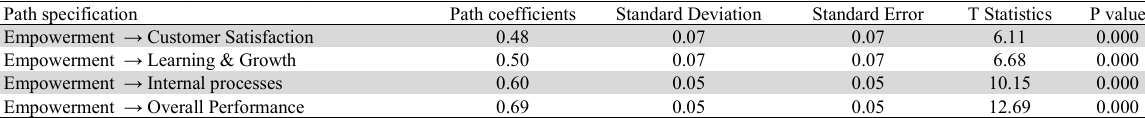
The result of PLS regression using bootstrapping procedures